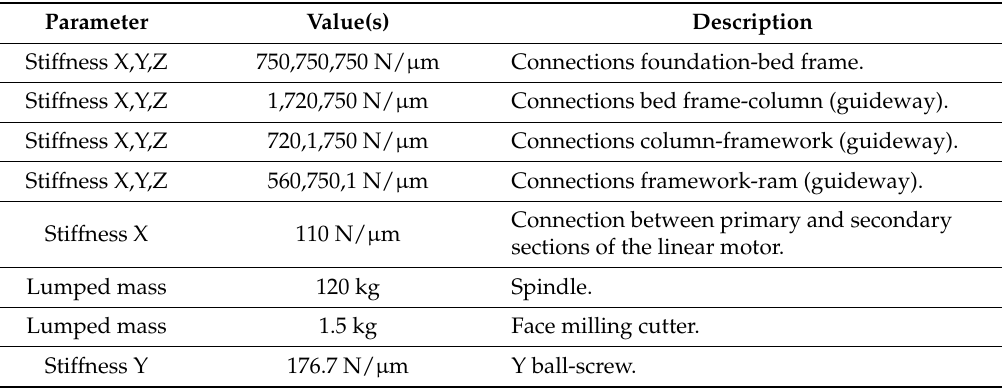
Figure 1. Finite element (FE) model of the machine tool. Table 1. Main parameter values of the finite element (FE) model.